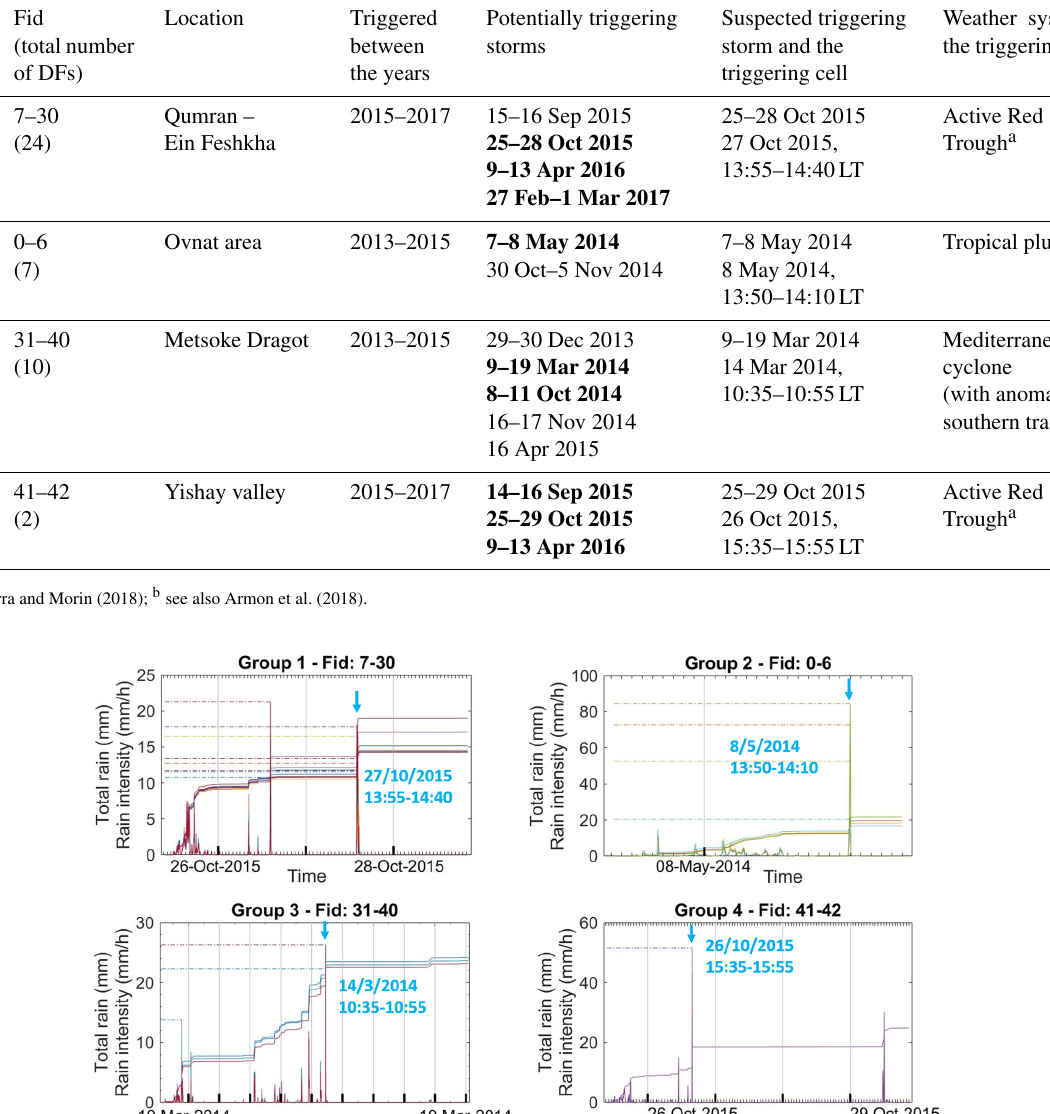
Table 1. Potential triggering storms and suspected triggering convective cells for the 43 DFs, organized into four groups. The DFs are numbered by Fid, which is the object ID of a shapefile in ArcGIS Desktop, and in parenthesis the total number of DFs in a group is given. The weather system that produced the storms is also reported. Bold fonts indicate the potential triggering storms.